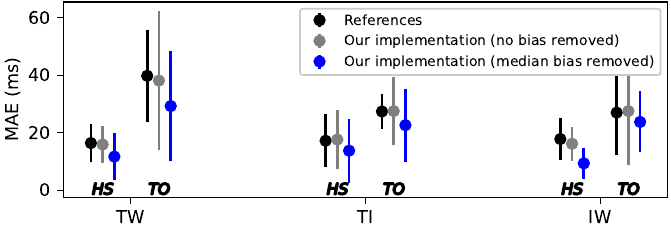
Figure 6. Average (dots) and ± 1 standard deviation (error bars) of the MAE for the values reported in reference [10] and our own implementation of the TKEO algorithm, under conditions of treadmill walking (TW), treadmill incline (TI) and indoor walking